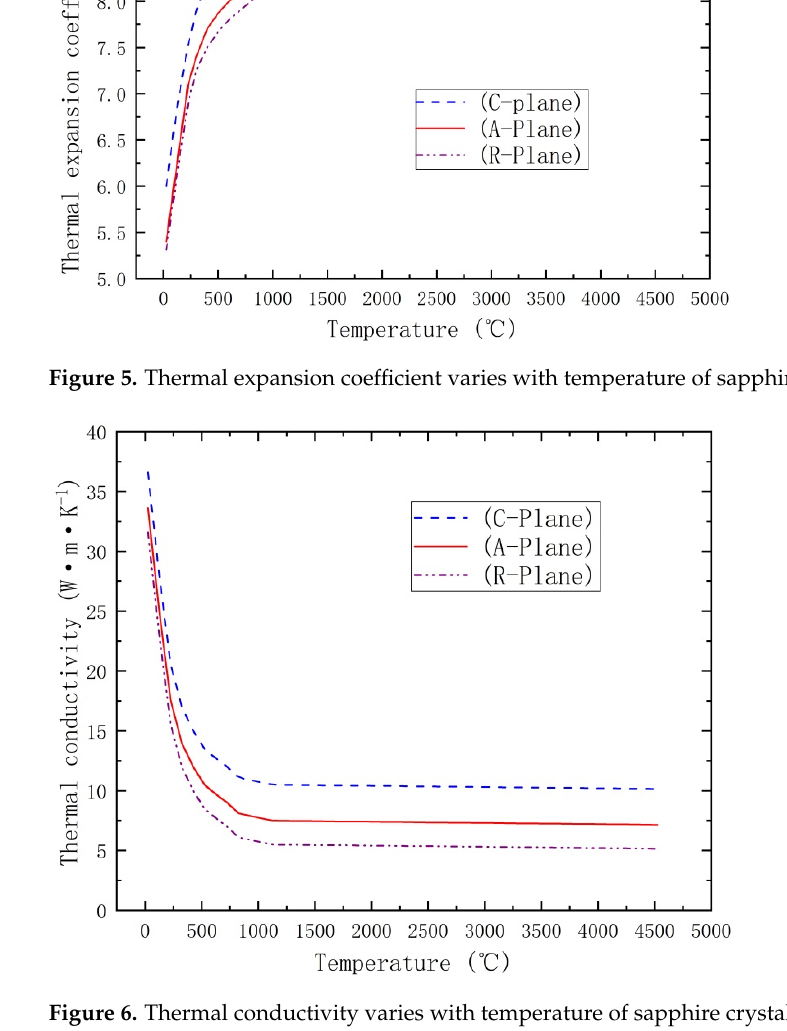
Figure 6. Thermal conductivity varies with temperature of sapphire crystal.